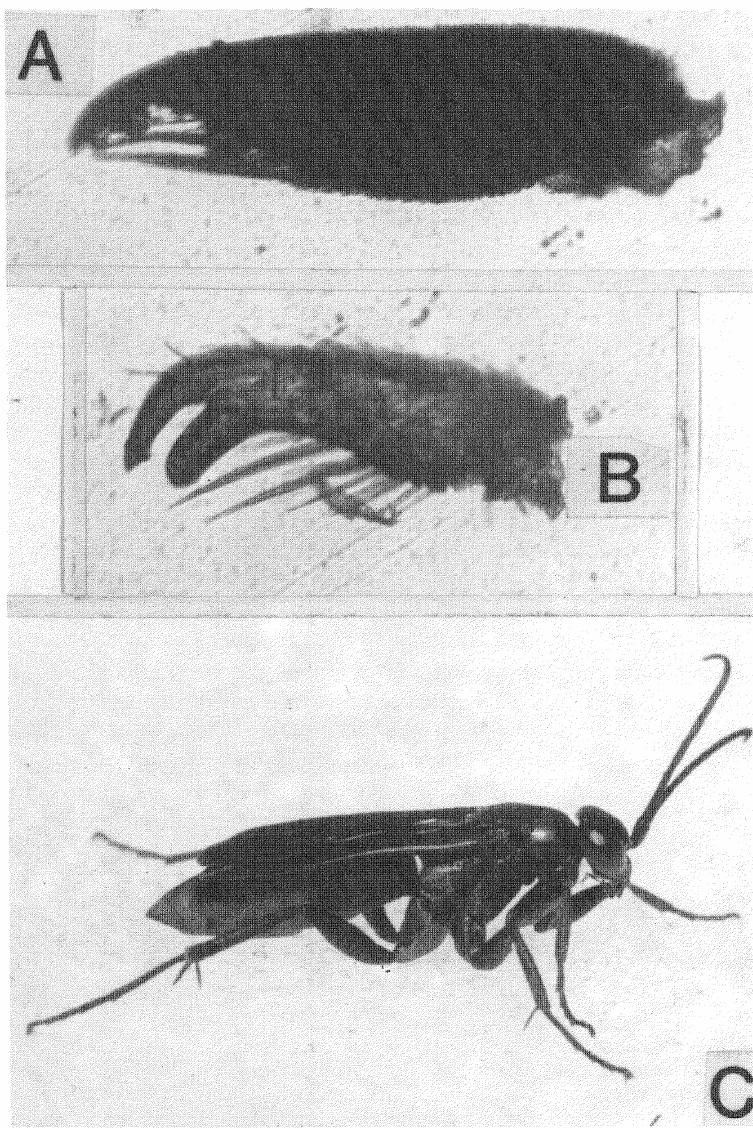
Fig. 1. A, Claw of Allochares azureus; B, claw of Episyron conterminus; C, A. azureus,